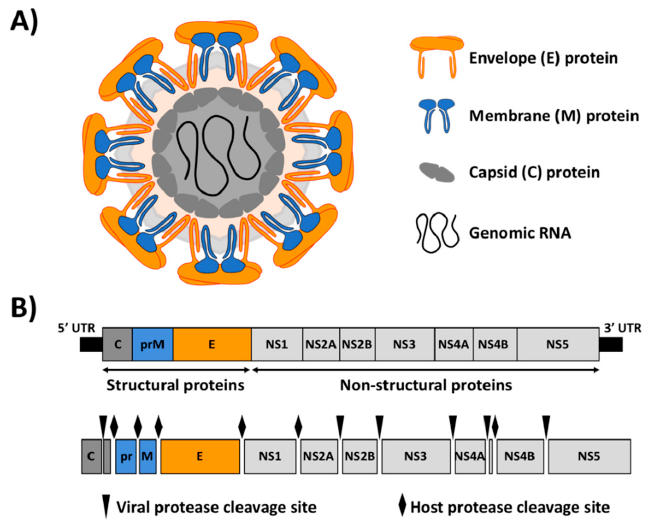
Figure 1. Zika virus (ZIKV) virion structure and genome organization. ( A ) Schematic representation of ZIKV virion structure: ZIKV virion surface is decorated with the E and M proteins, anchored in a lipid bilayer with an icosahedral-like symmetry. Under the viral lipid bilayer is the nucleocapsid composed of the vRNA genome associated with the C protein. ( B ) Genome organization and polyprotein processing: ZIKV genome (approximately 10.8 kb) is translated as a single polyprotein that is cleaved co- and post-translationally by viral (arrows) and host (diamonds) proteases to yield the three structural proteins C, M and E; and seven NS proteins NS1, NS2A, NS2B, NS3, NS4A, NS4B and NS5. The 5 (cid:48) and 3 (cid:48) untranslated regions (UTR) are indicated as black lines at the end of the viral